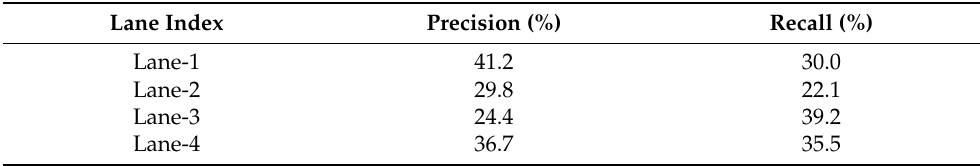
Table 6. Classification Result of ResNet50 (perception image).